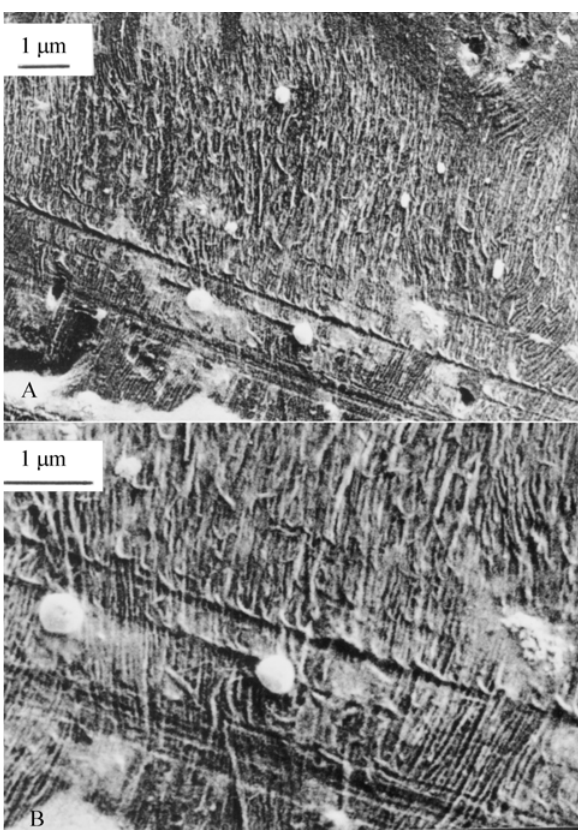
Figure 8. Tangential view of transcrystalline HDPE matrix lamellae from region S 1 (see Fig. 7 for sample location). Magnification 7.500X in (a), 15.000X in (b).